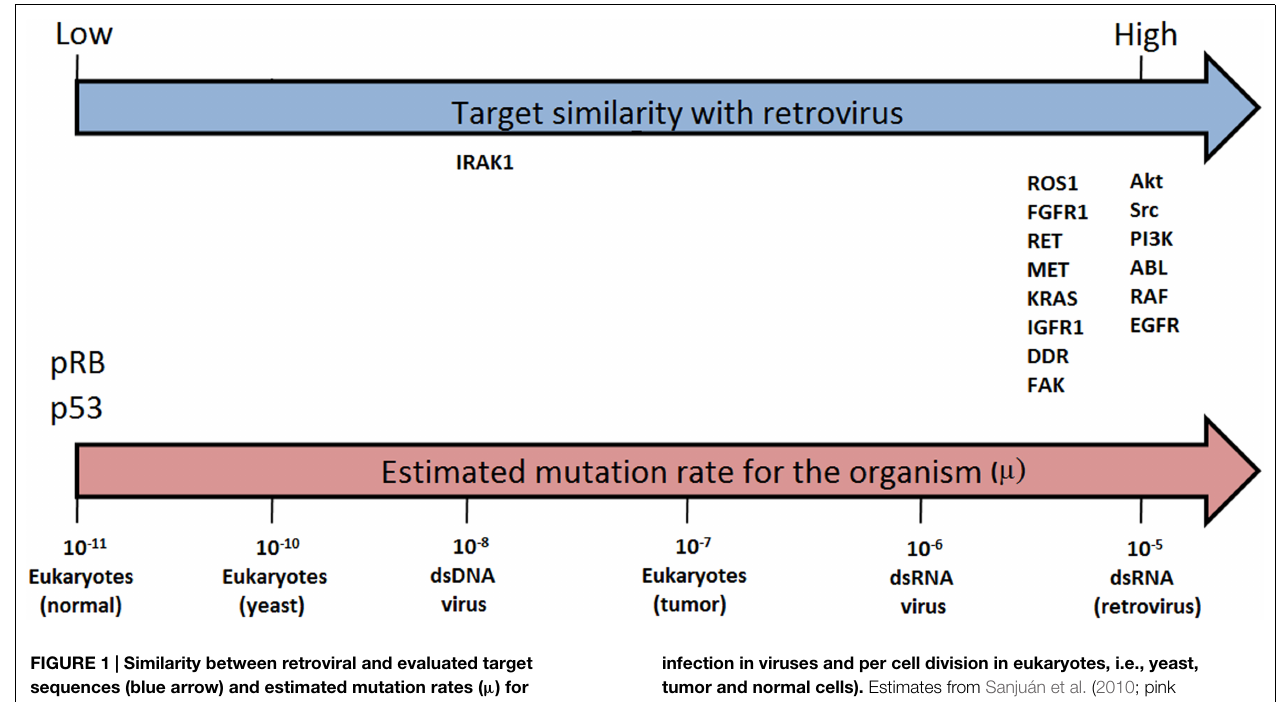
FIGURE 1 | Similarity between retroviral and evaluated target sequences (blue arrow) and estimated mutation rates ( m ) for selected organisms ( m = substitutions per nucleotide per cell